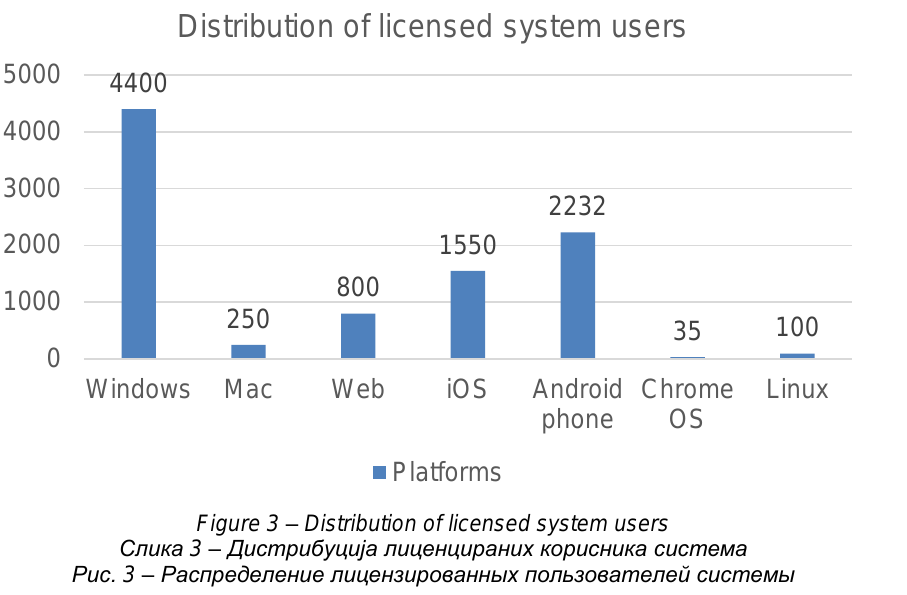
Figure 3 – Distribution of licensed system users Слика 3 – Дистрибуција лиценцираних корисника